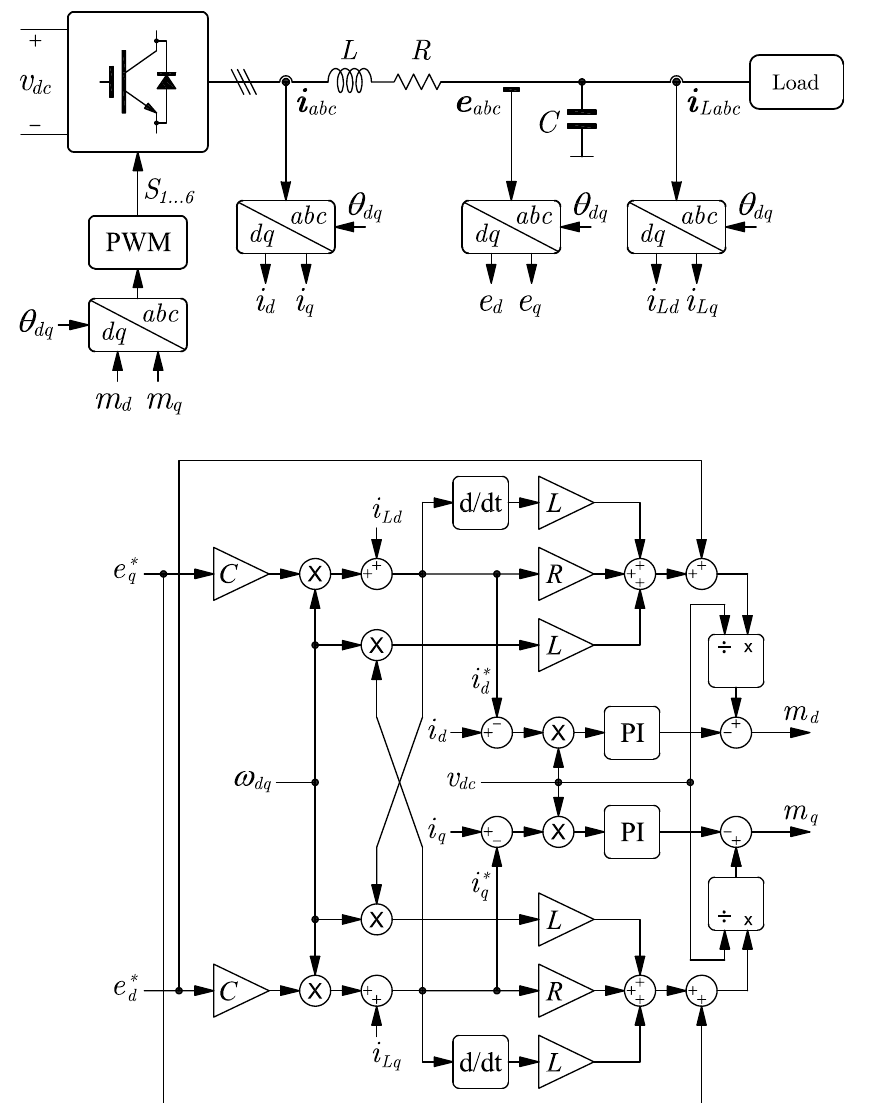
Figure 3. Block diagram of the proposed